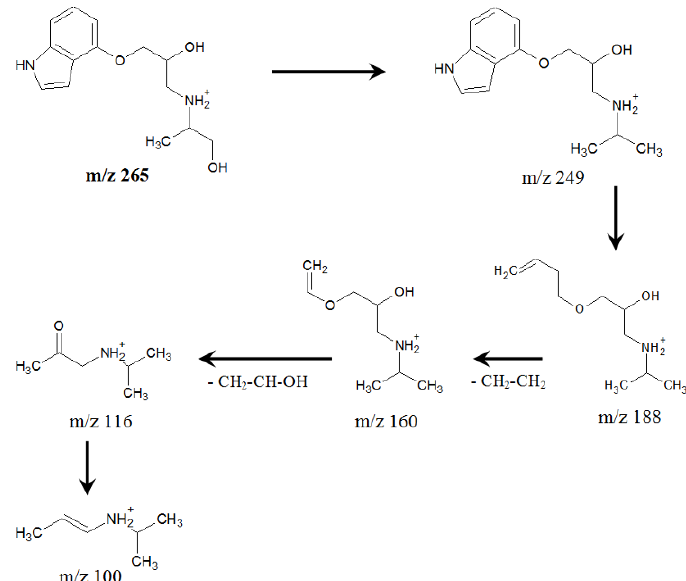
Figure 6. Main fragmentation pathways for radiolysis products for